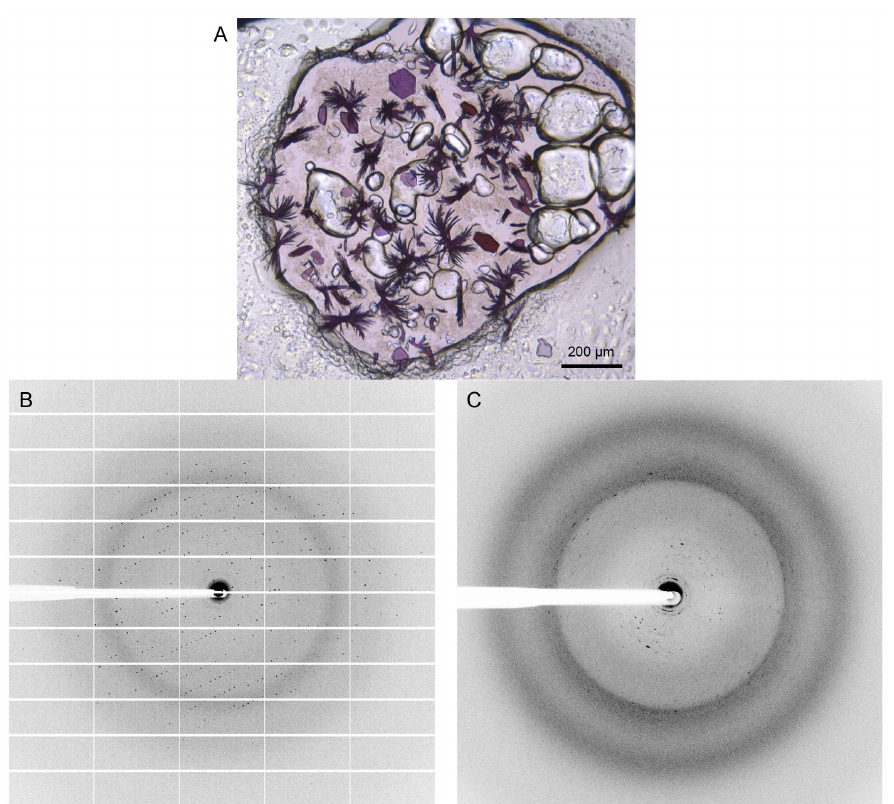
Figure 2. Hm BRI crystals and diffraction. (A) Hm BRI crystals in the crystallization well. Two types of crystals are observed: regular shaped hexagonal crystals and bunches of needles. (B) Example of the diffraction from the hexagonal crystals. Resolution at the detector edge is 2.4 A˚. (C) Example of the diffraction from needle-shaped crystals. Resolution at the detector edge is 2.5 A˚ . The diffraction patterns are smeared and observed up to the resolution of 3.5